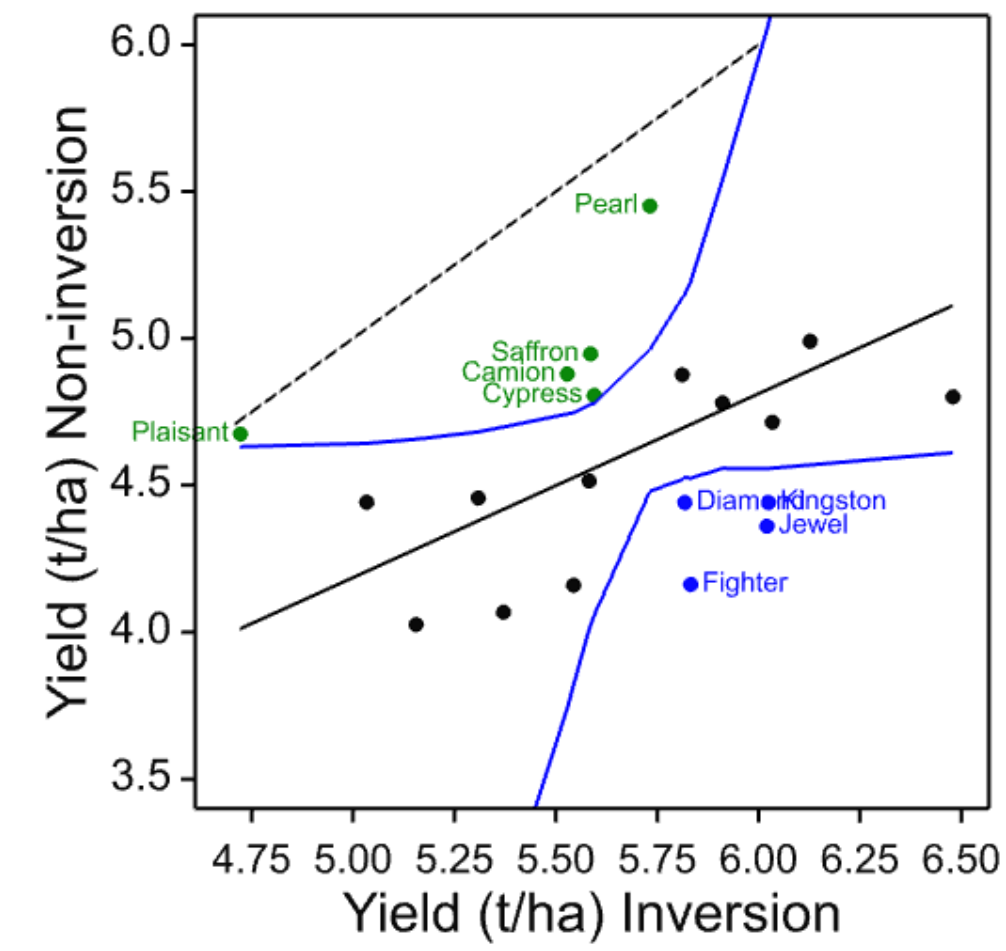
Figure 12. Regression of non-inversion yield on inversion yield for 20 winter barley cultivars common to all 2008, 2011 and 2012 trials. The blue lines show the 95% confidence interval of the regression line (solid black), while the dashed line shows the 1:1 yield ratio. Only cultivars outside the confidence limits are labelled for clarity, blue below and green above, i.e., the most adapted cultivars highlighted in Table 14.